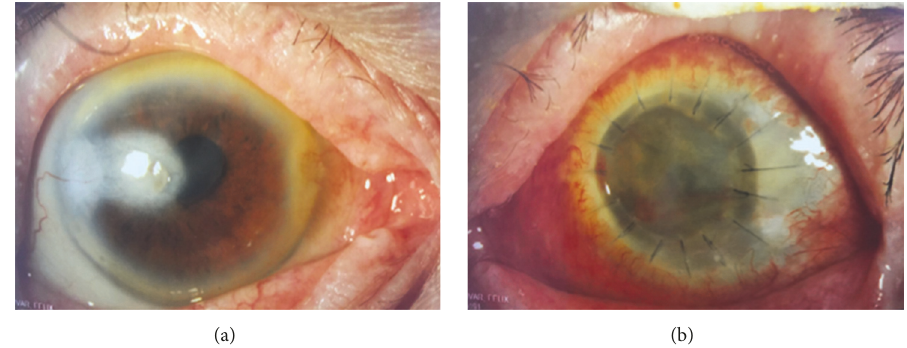
Figure 3: Slit-lamp photographs of the right eye (a) demonstrate paracentral corneal scar with no signs of infection and left eye (b) clear corneal graft with poor detail of anterior